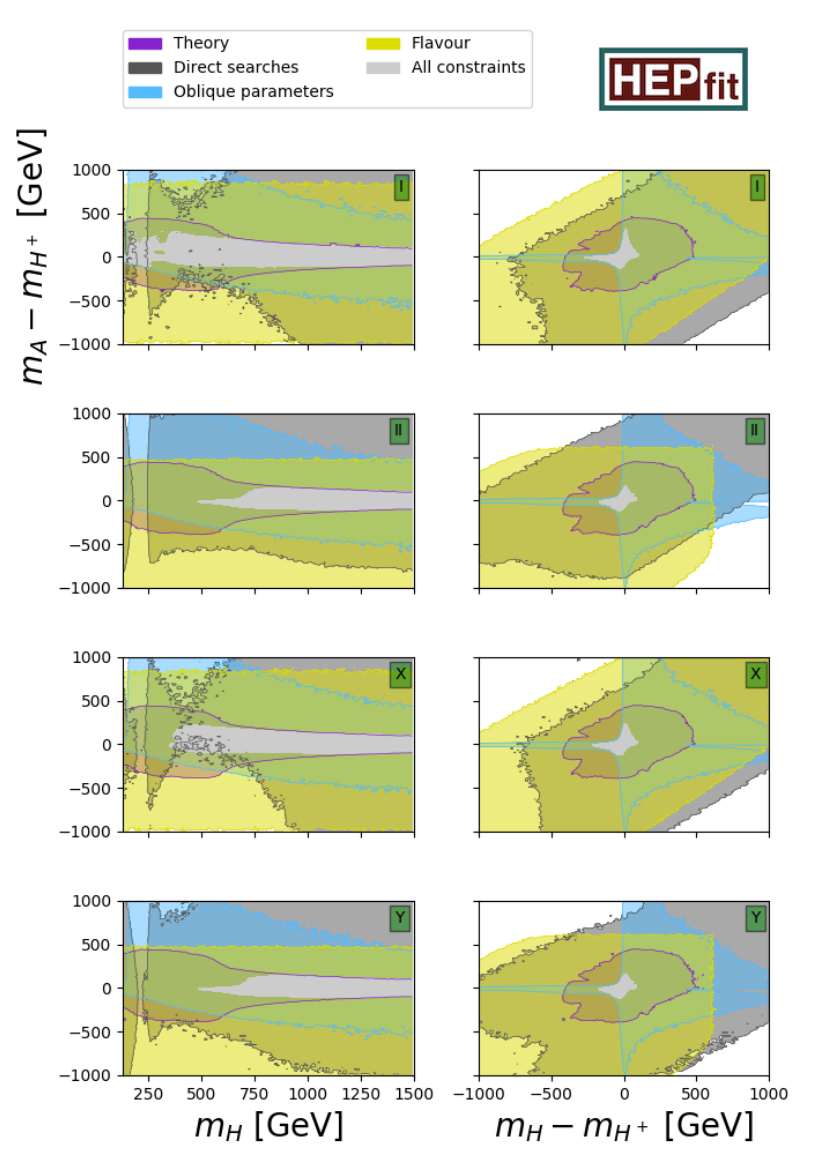
Figure 5 . In the m A (cid:0) m vs. m H (left panels) and m A (cid:0) m vs. m H (cid:0) m (right panels) H + H + H + planes we show the allowed regions by various sets of constraints: the heavy Higgs searches, the oblique parameters and the (cid:13)avour observables determine the 95.4% allowed contours in dark grey, light blue and yellow, respectively. For the theoretical constraints, the 99.7% regions are given by the purple shaded areas. We superimpose the 95.4% probability combination from the global (cid:12)t to all observables in light